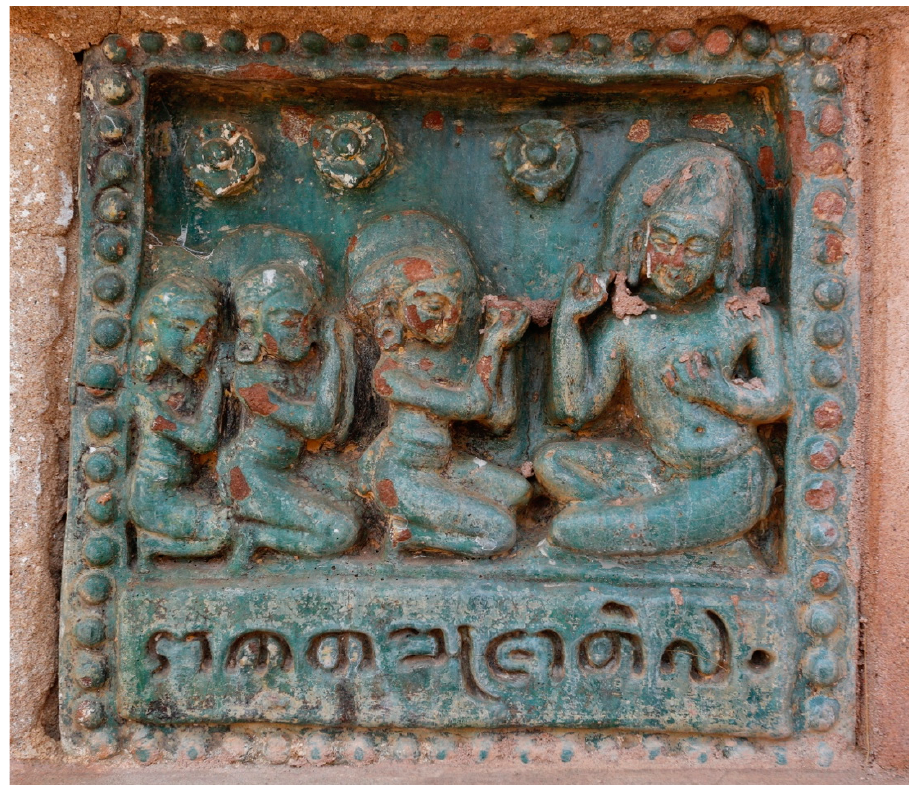
Figure 30. Pagan, Kutha, 13th century. Two vimanas allocated for animals.